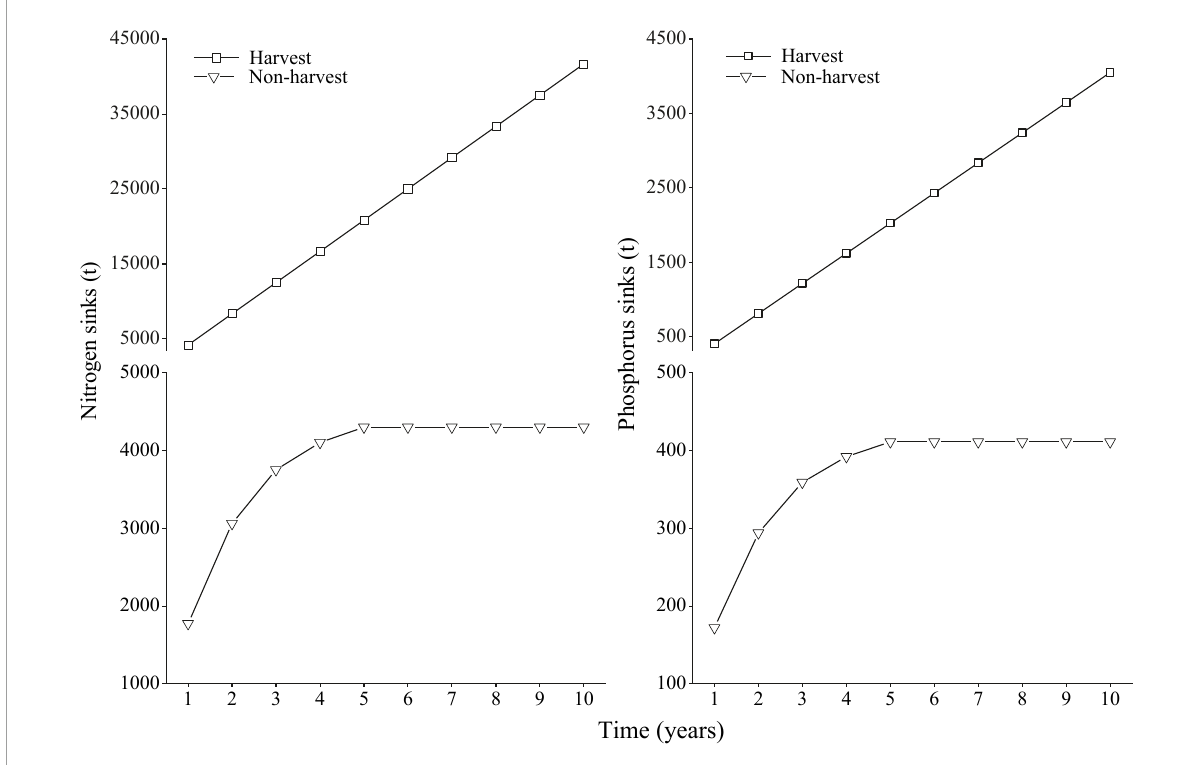
FIGURE6 Nitrogen and phosphorus sinks in the scenarios of harvest and non-harvest of M. lutarioriparius in the Dongting Lake wetlands over time.